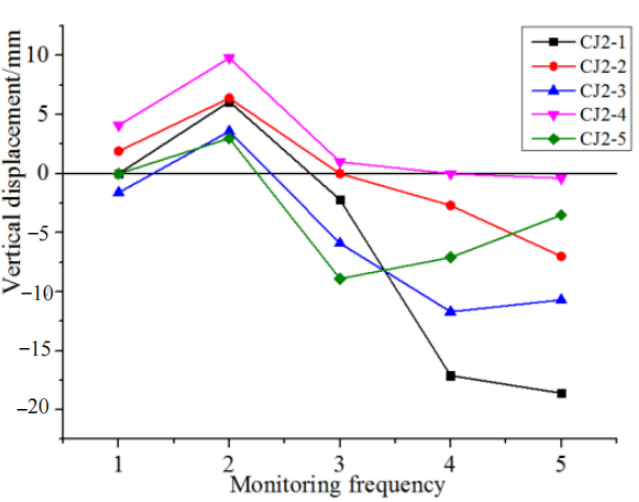
Figure 14. Vertical displacement curves.